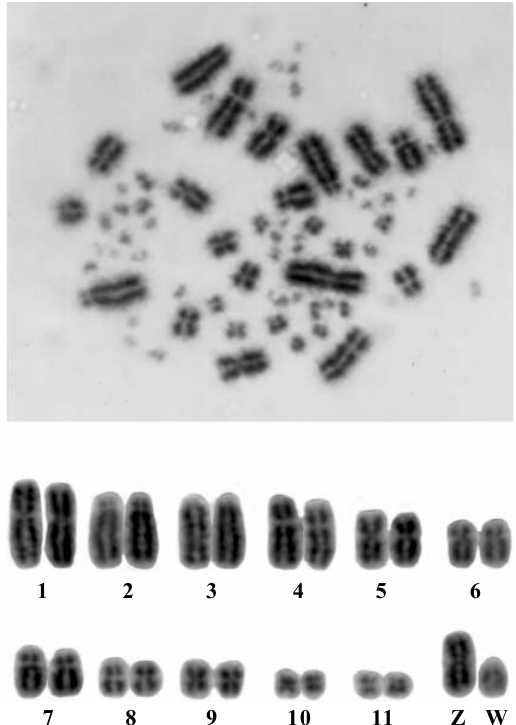
Figure 2 - Mitotic metaphase and female karyotype of Platalea ajaja .